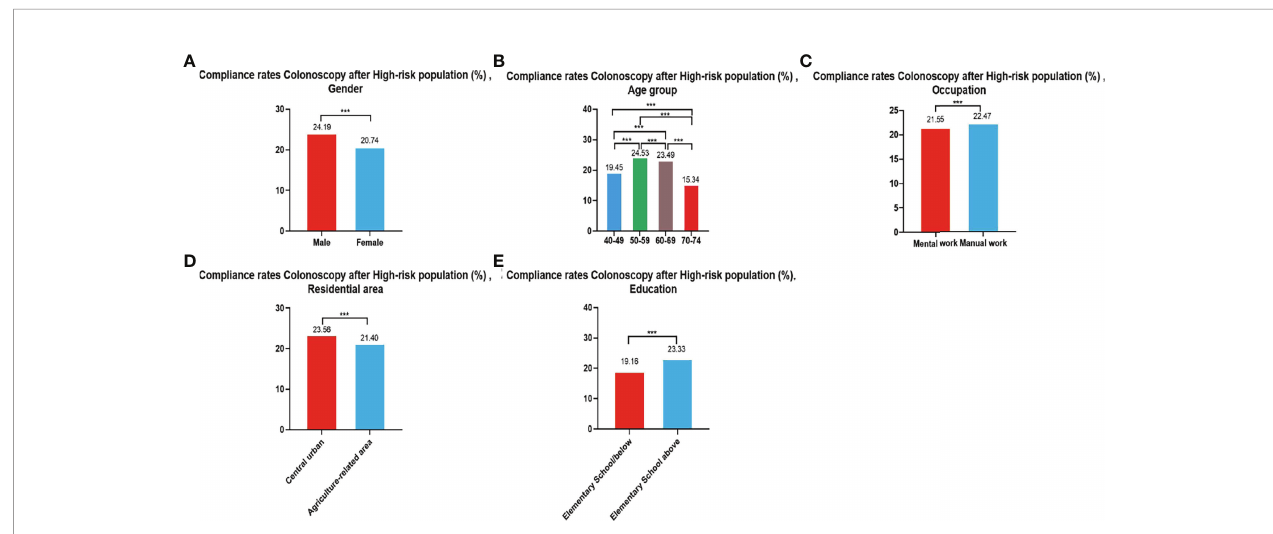
FIGURE 4 | Compliance results by gender (A) , age group (B) , occupation (C) , residential area (D) , education (E) of subsequent colonoscopy in the high-risk population. ***There are signi fi cant differences in detection rates between the different screening